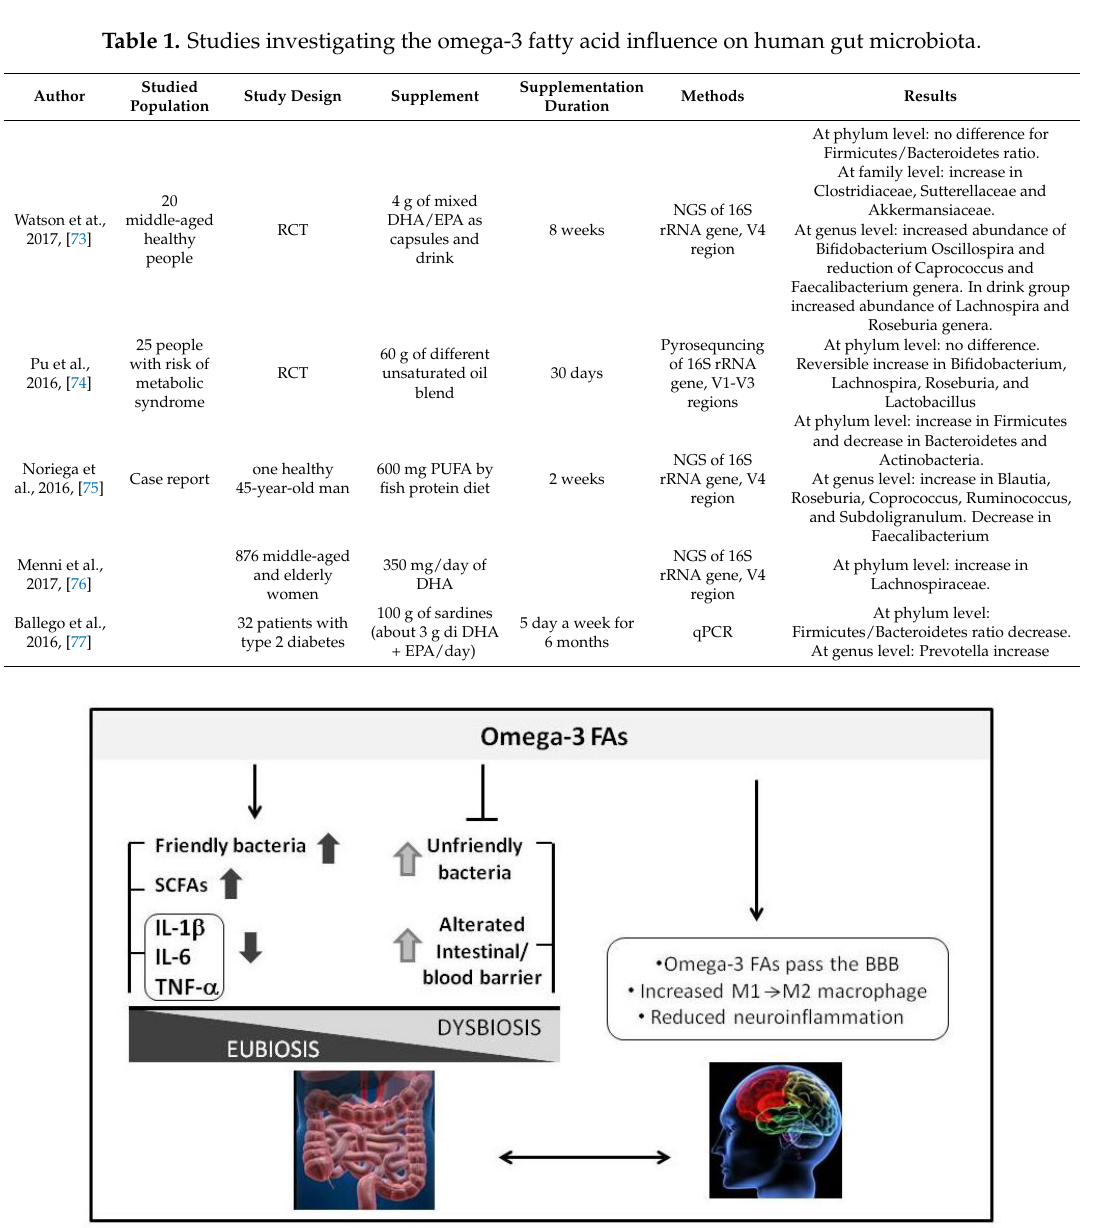
Figure 2. Possible effects of an omega-3 fatty acid (FA)-rich diet on microbiota and the brain. Omega-3 FAs lead to increases in host-friendly bacterial genera ( Eubacterium, Anaerostipes , Roseburia , Subdoligranulum, Coprococcus and Pseudobutyrivibrio ) associated with SCFA